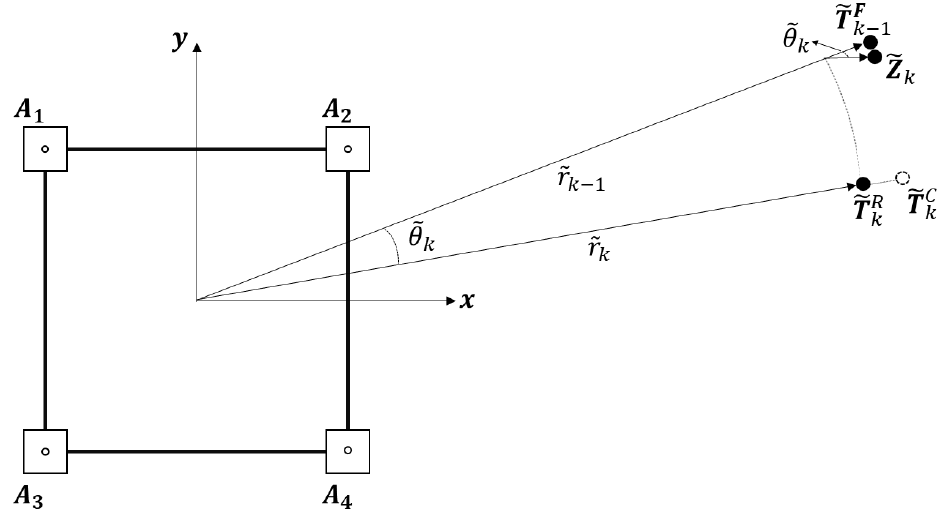
Figure 5. Computing estimation candidate 𝒁̃ 𝑘 from previous estimation 𝑻̃ 𝑘−1𝐹 .